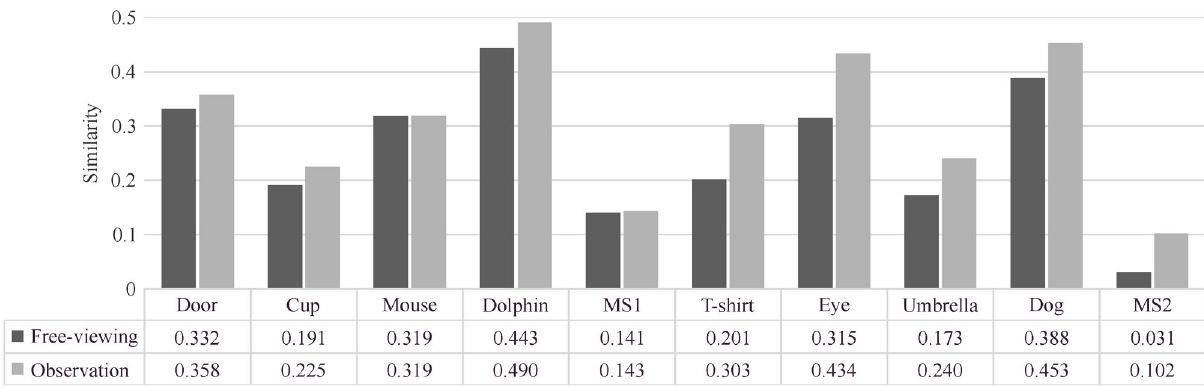
Fig. 6 Similarities between the PPFs and fixation maps.